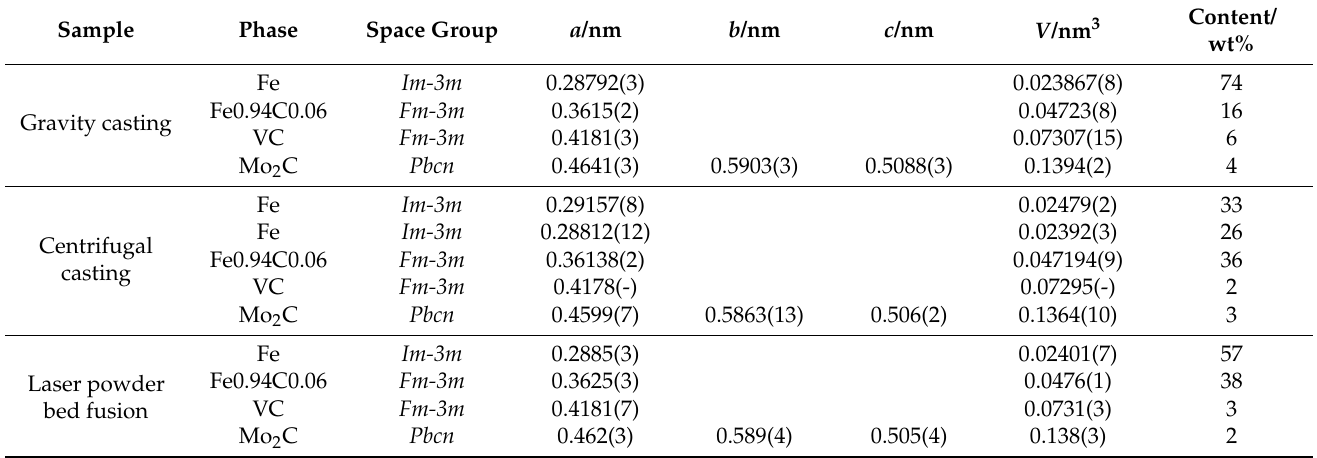
Figure 2. SEM and EBSD data of Fe85Cr4Mo8V2C1 after centrifugal casting: ( a ) fore scattered diffraction image showing the microstructure for the EBSD point analyses; ( b ) SEM image of the carbide morphology; and ( c ) experimental Kikuchi pattern of the point analyses with best fit solution of the simulated pattern as overlay. For the evaluation of the fit, the number of matched bands (B) and the band mismatch (M) are given. Table 1. Structure models, lattice parameters and phase contents of martensite, austenite and